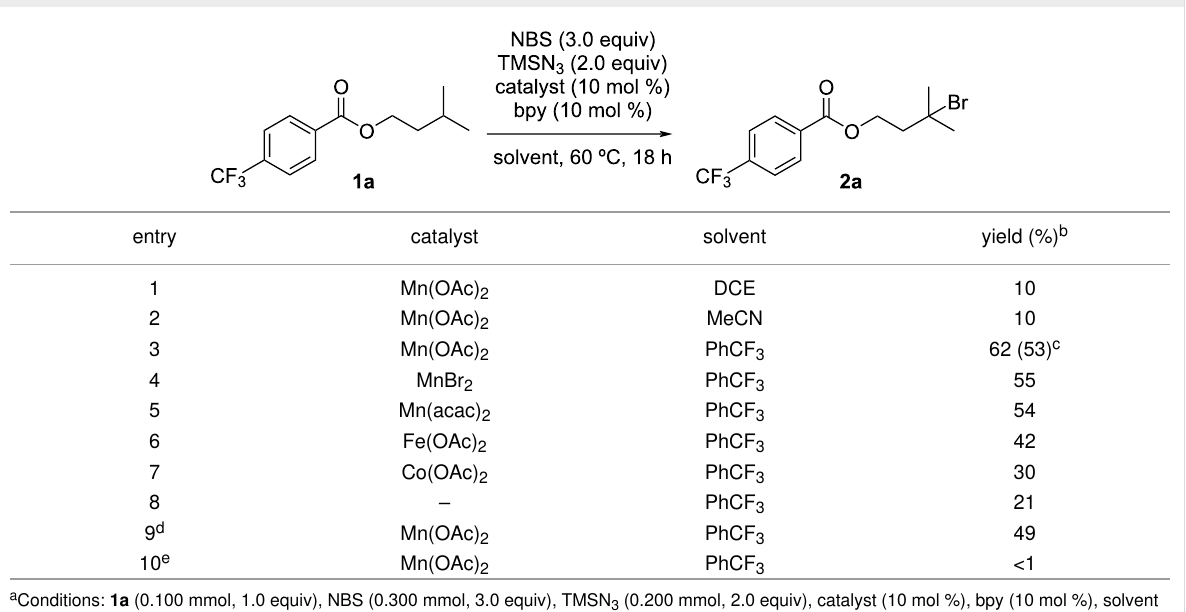
Table 1: Optimization of reaction conditions a